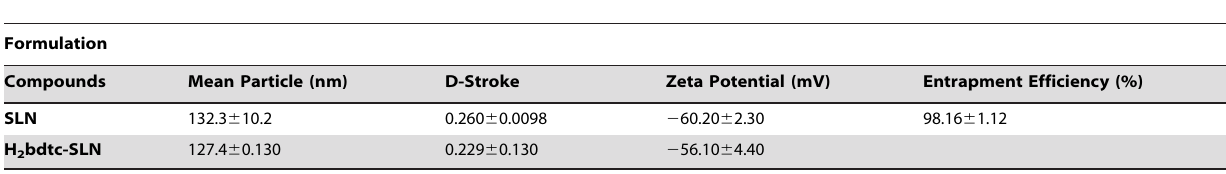
Table 1. Particle size, zeta potential, dispersity index and entrapment efficiency of SLNs (mean 6 SD, n =3).